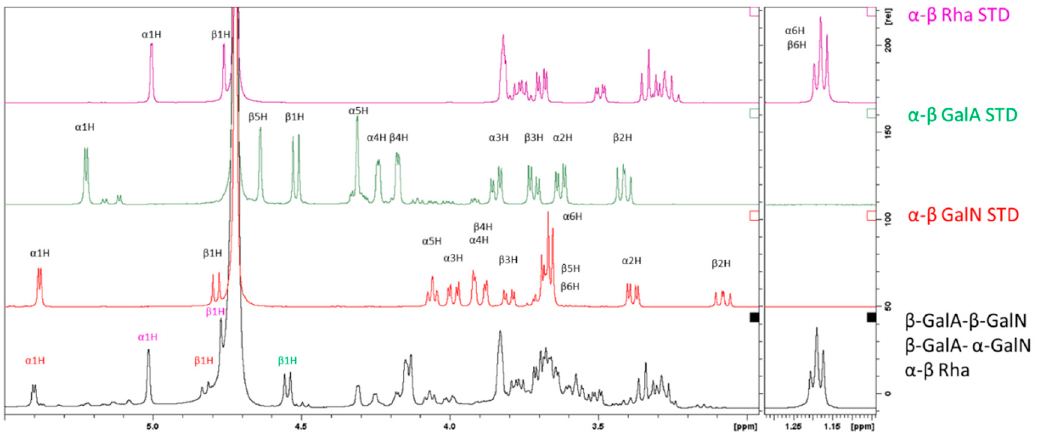
Figure A8. 1 H NMR spectrum of the hydrolyzed S. flexneri 6 OAg containing dimer GalA-GalN (black) in comparison with the standard sugars of Rha (violet), GalA (green) and GalN (red).